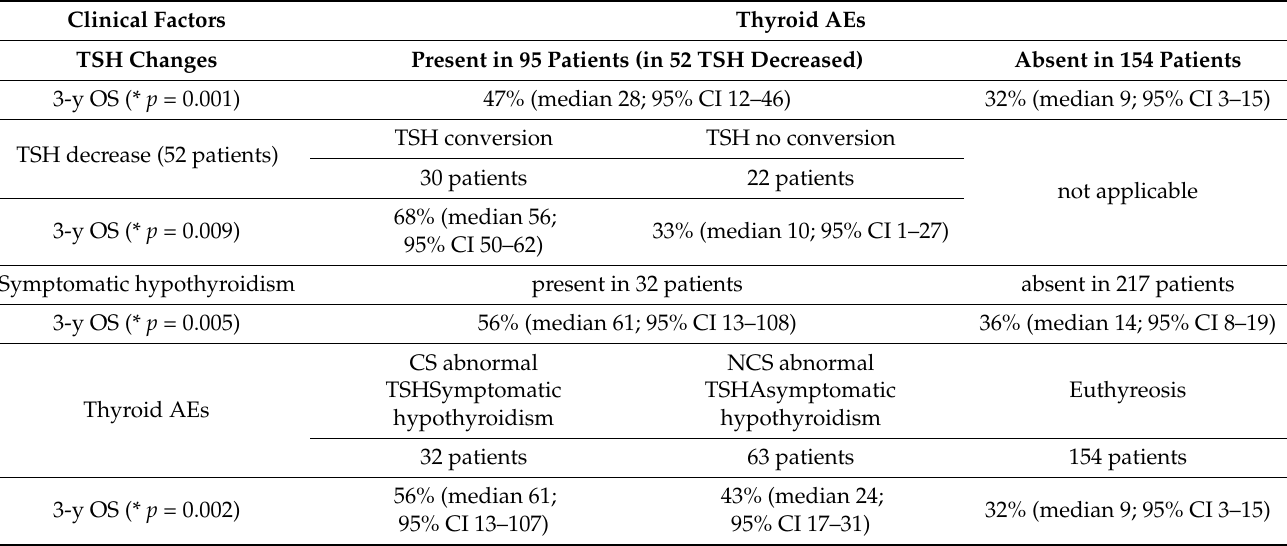
Figure 1. ( a – e ) Kaplan Meier survival curves depending on: ( a ) TSH changes, ( b ) TSH conversion, ( c ) clinical hypothyroidism, ( d ) thyroid AEs, and ( e ) thyroid AEs adjusted to the length and lead-time bias. (time provided in months). Table 2. The pattern of occurrence of TSH changes and clinical thyroid AEs.